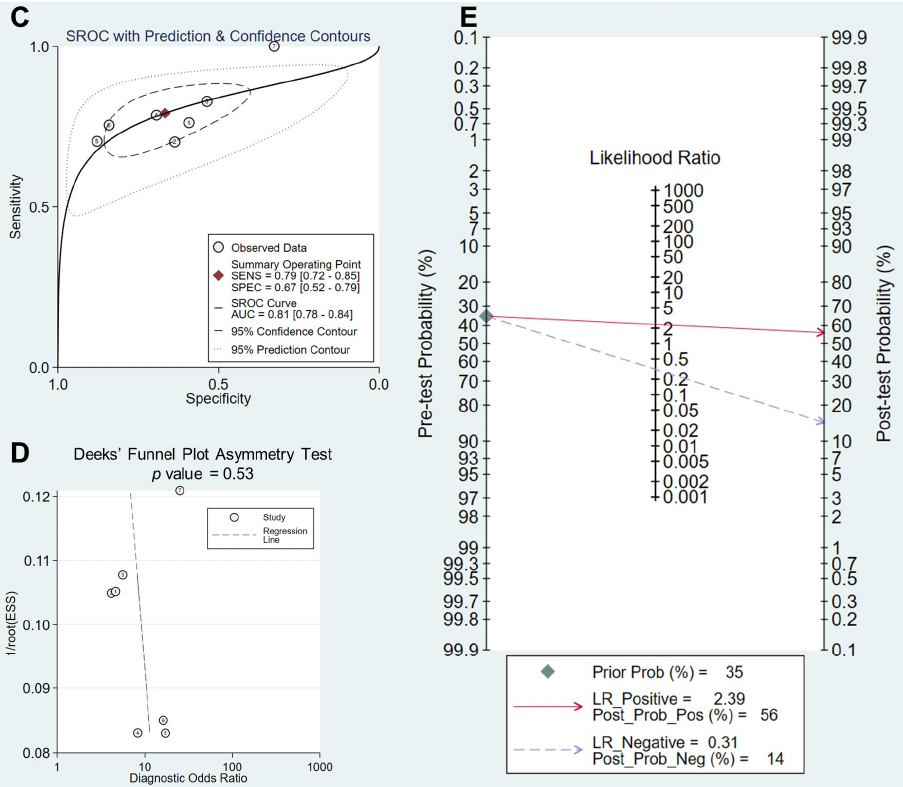
Figure 2. Pooled predictive performance of extracellular sncRNAs for embryo implantation potential. Data from three published articles [45,55,59] were analyzed. ( A ) Forest plots of the pooled sensitivity. ( B ) Forest plots of the pooled specificity. ( C ) SROC curve. ( D ) Deeks’ funnel plot. ( E ) Fagan’s plot.